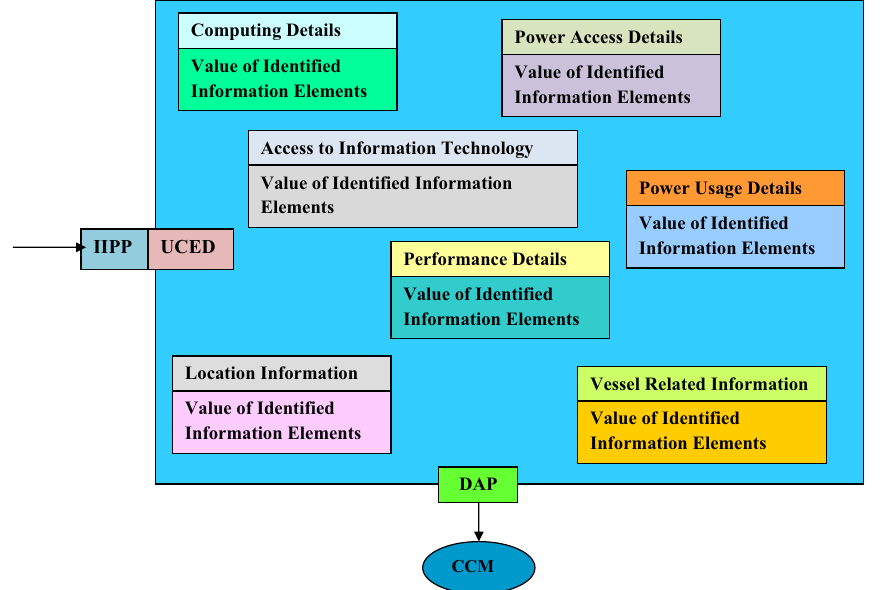
Figure 8. Relations between the IIPP, UCED, DAP, information elements and access by the